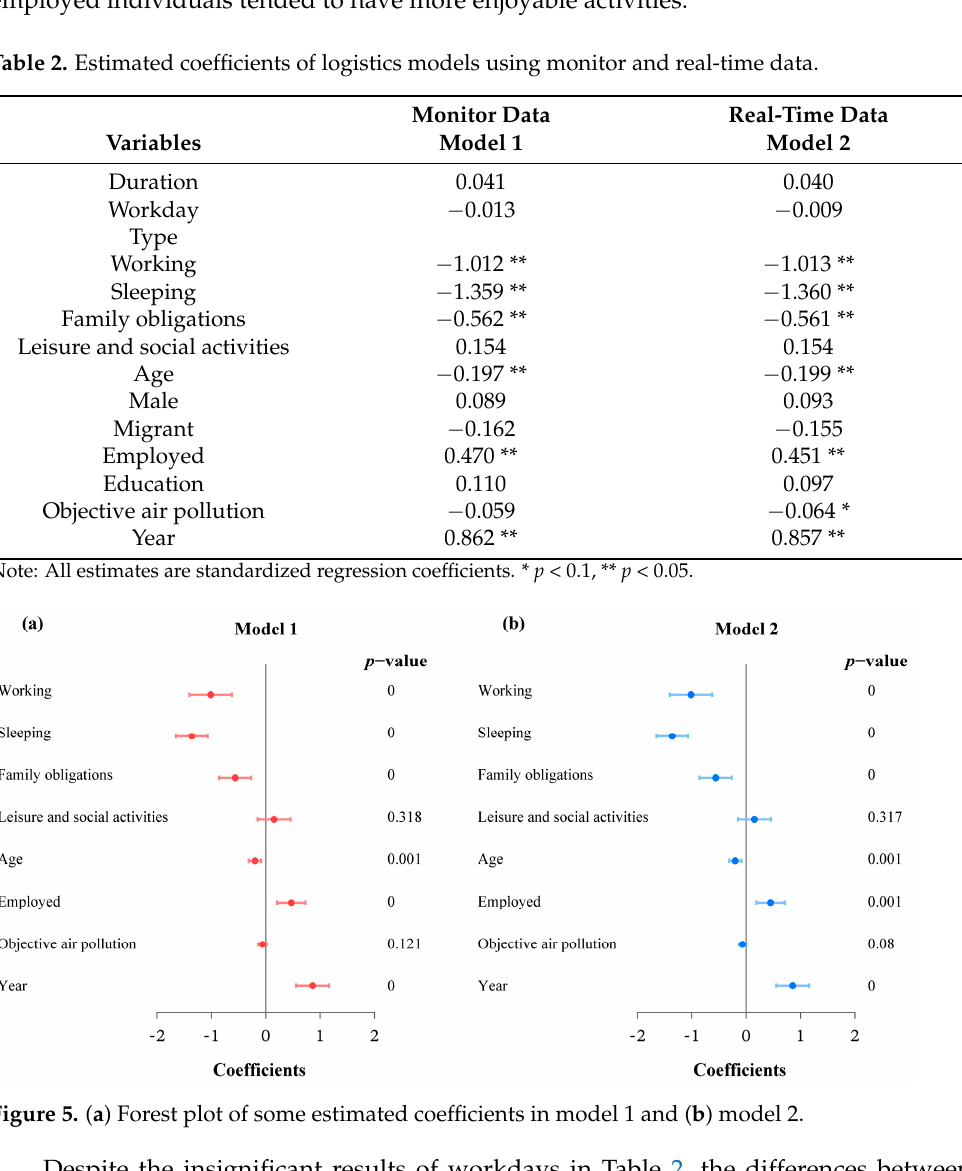
Table 3. Estimated coefficients of logistics models by workday and weekend